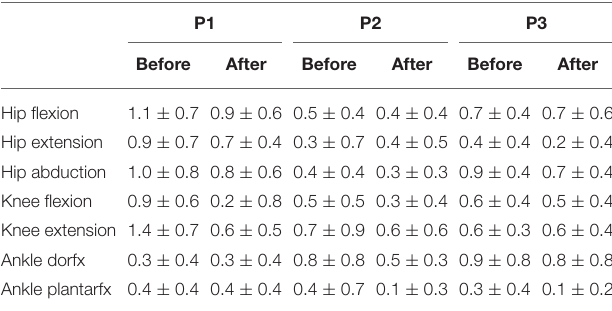
Dorfx, dorsiflexion; plantarfx, plantarflexion; P, patient.